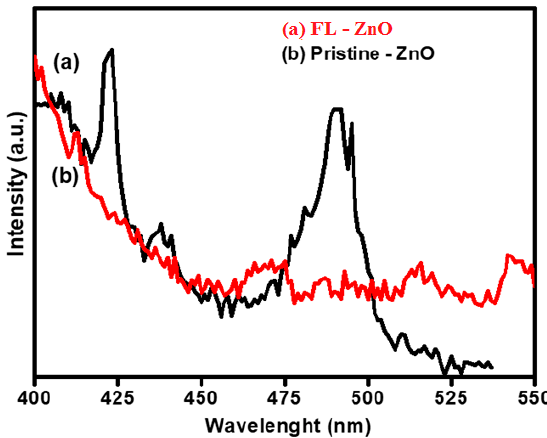
Figure 6. Photoluminescence spectra of ZnO materials excited at 390 nm excitation wavelength ( a ) FL–ZnO and ( b ) Pristine ZnO .